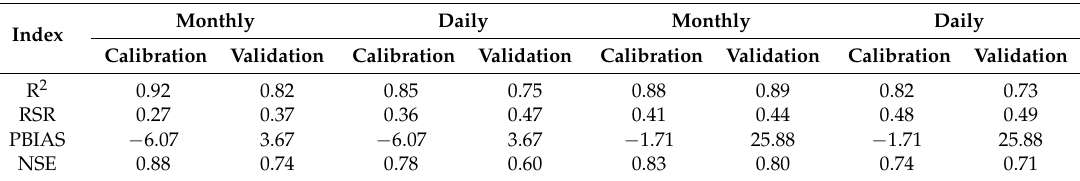
Table 1. SWATDRAIN statistics for the Canagagigue Creek watershed on monthly and daily time steps streamflow and sediment loads (Adopted from 14). RSR, Root Mean Square Error; NSE, Nash Sutcliffe Efficiency; PBIAS, Percent